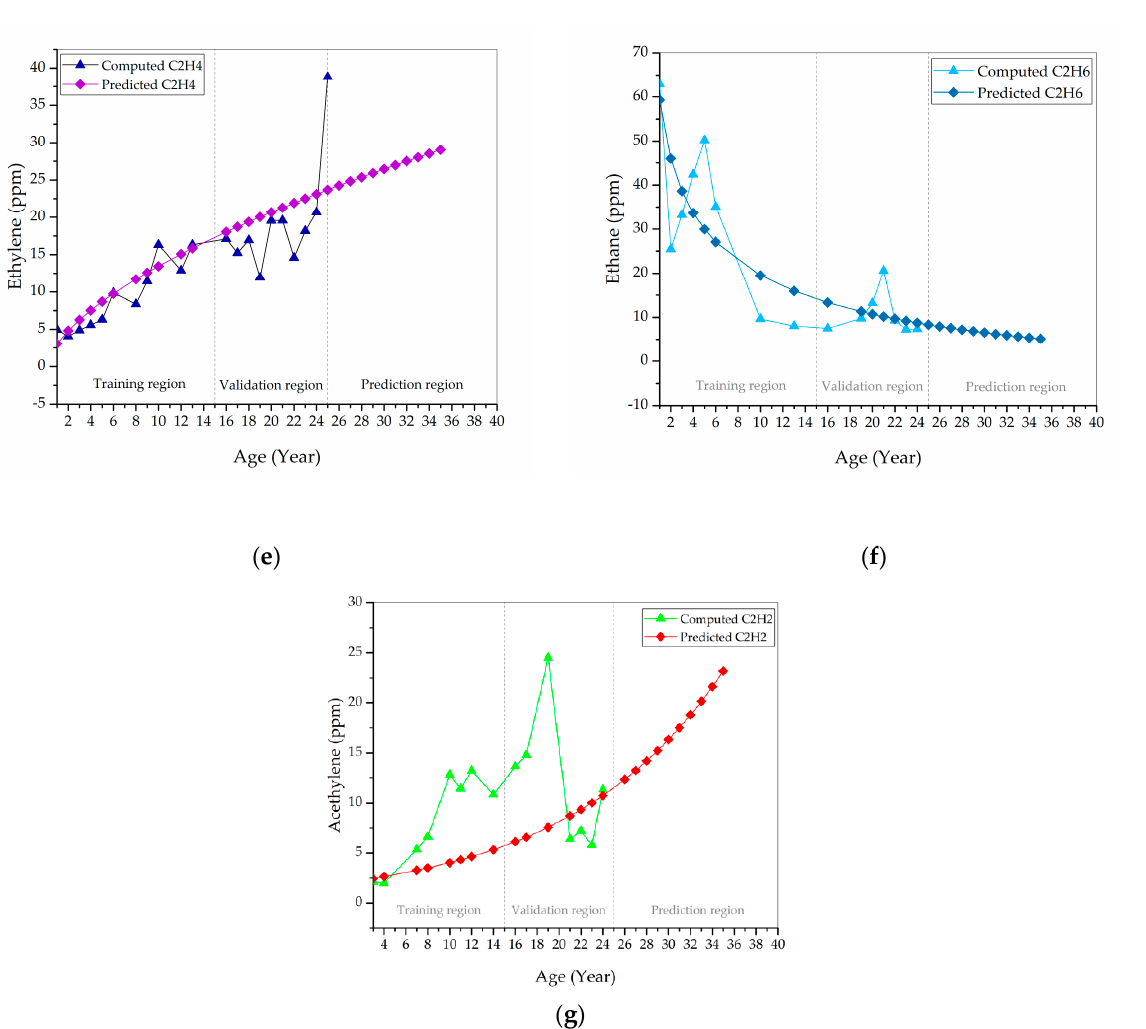
Figure 7. Comparison between computed and predicted ( a ) hydrogen; ( b ) methane; ( c ) carbon monoxide; ( d ) carbon dioxide; ( e ) ethylene; ( f ) ethane; and, ( g ) acetylene.